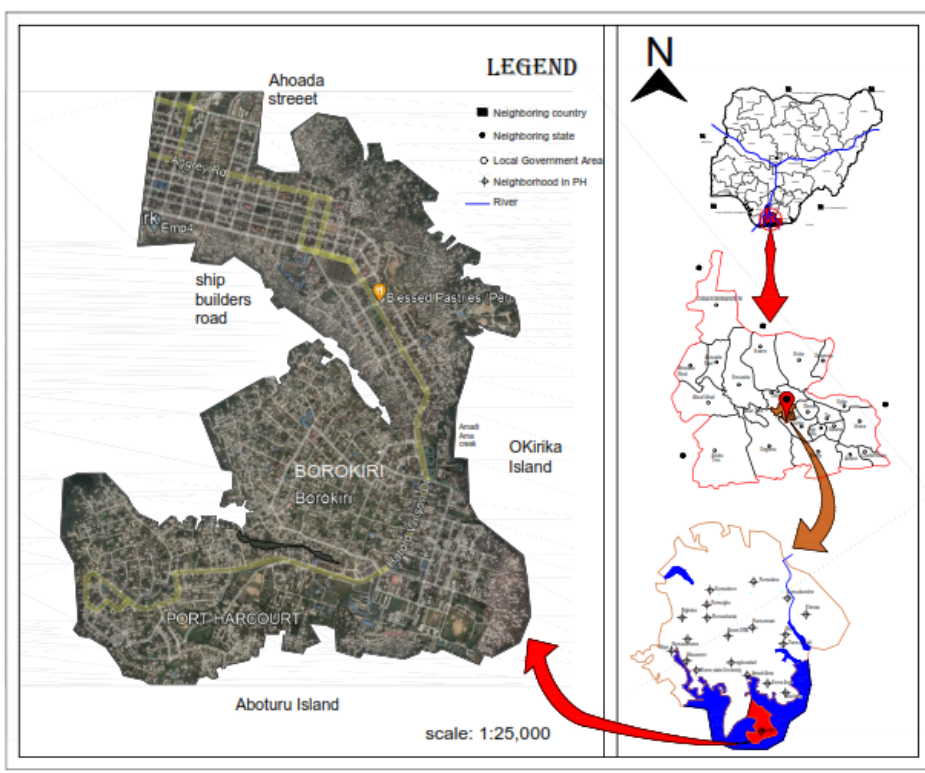
Figure 2. Map of Borokiri, the study